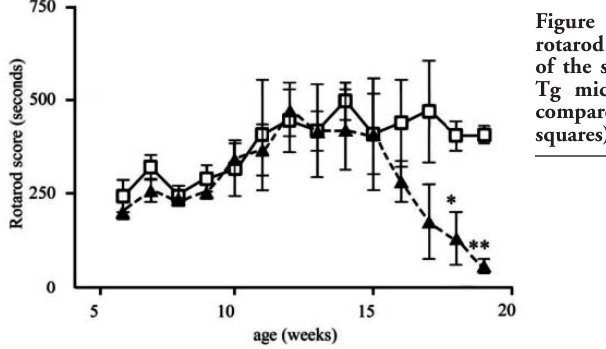
Figure 1. Clinical scores of rotarod tests. Note the decrease of the score after 15 weeks in Tg mice (filled triangles) as